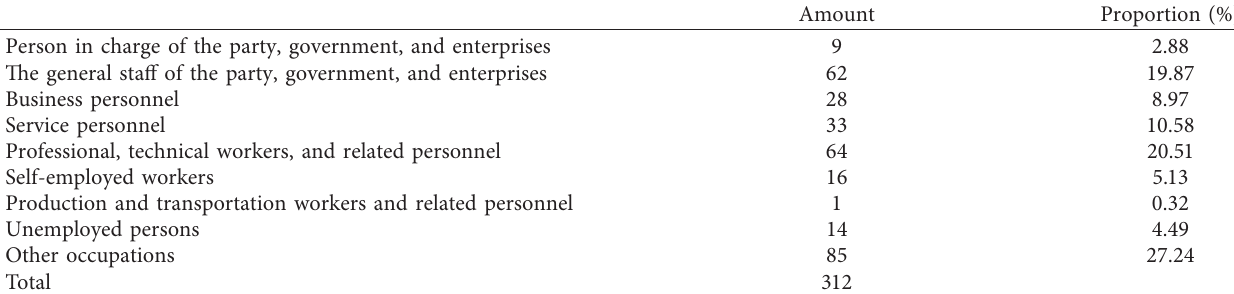
Table 5: Distribution of the respondents’ occupation.